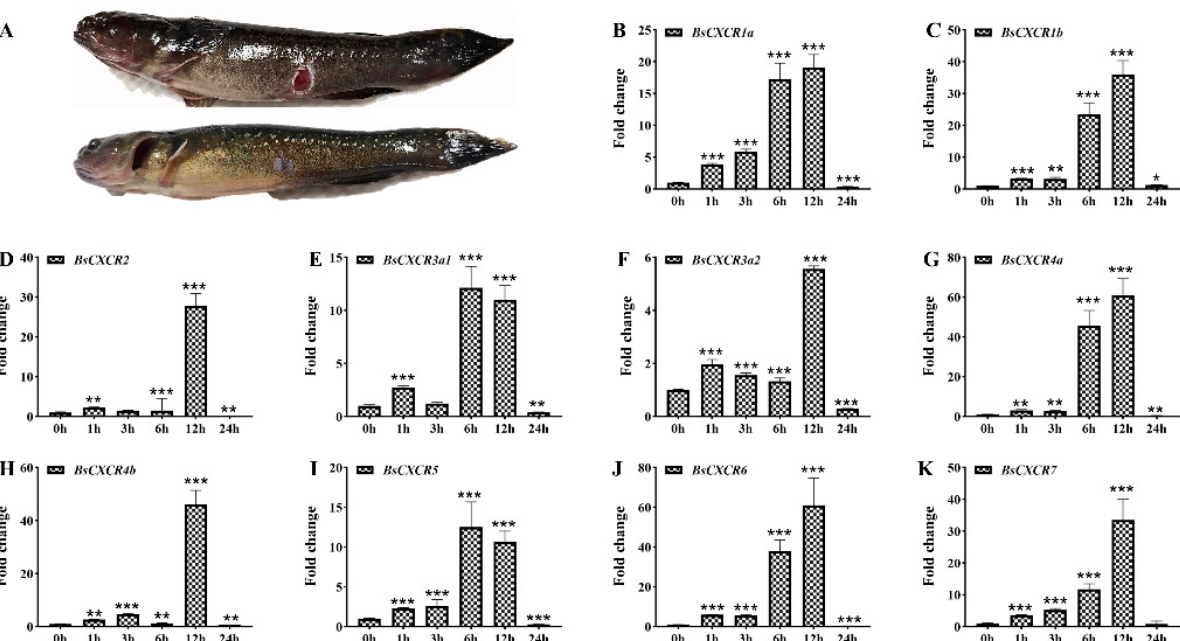
Figure 9. Dynamic expression patterns of BsCXCR during skin injury. ( A ) Representative image of four-eyed sleeper at 1 h (up) and 15 d (low) after injury, respectively. ( B – K ) The relative fold change of BsCXCR transcripts in the wounding sites of the skin at different times after injury (* p < 0.05; ** p < 0.01; *** p < 0.001).